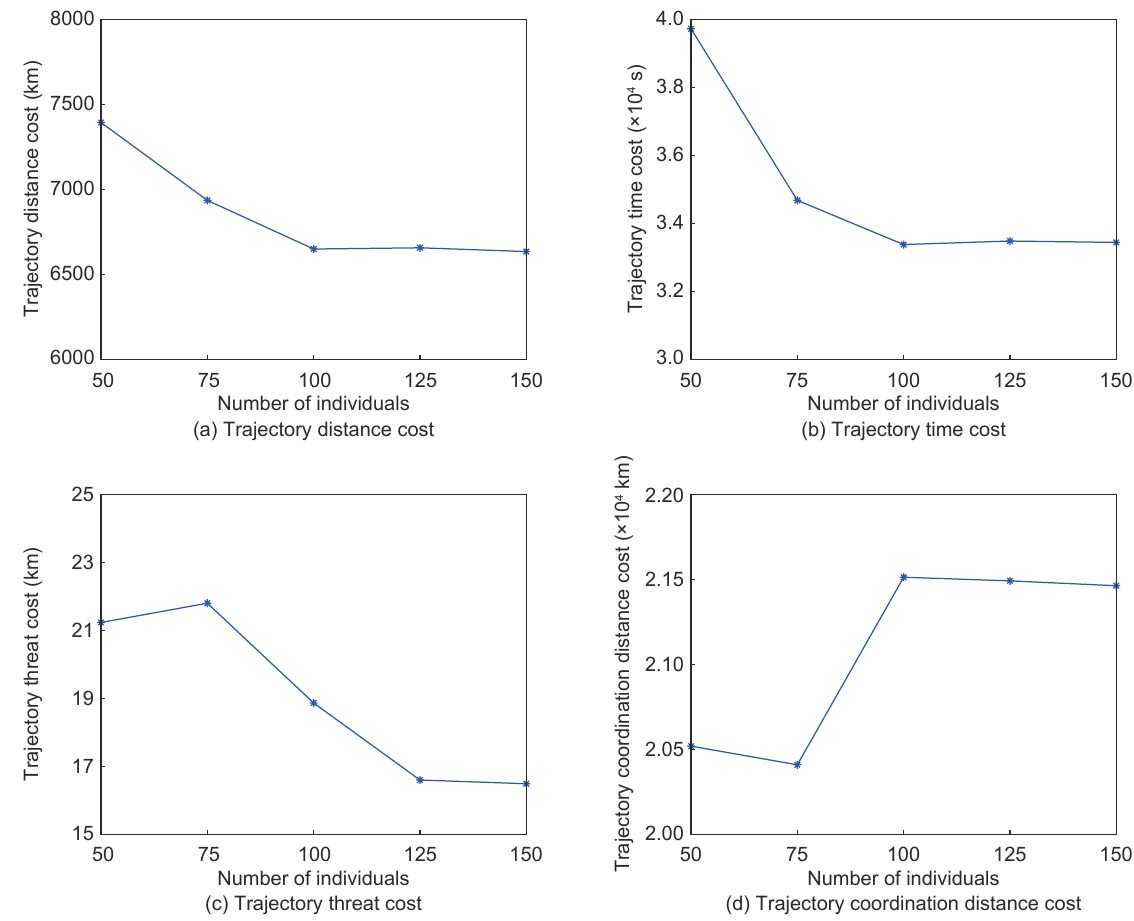
Fig. 4 Results of each objective at different